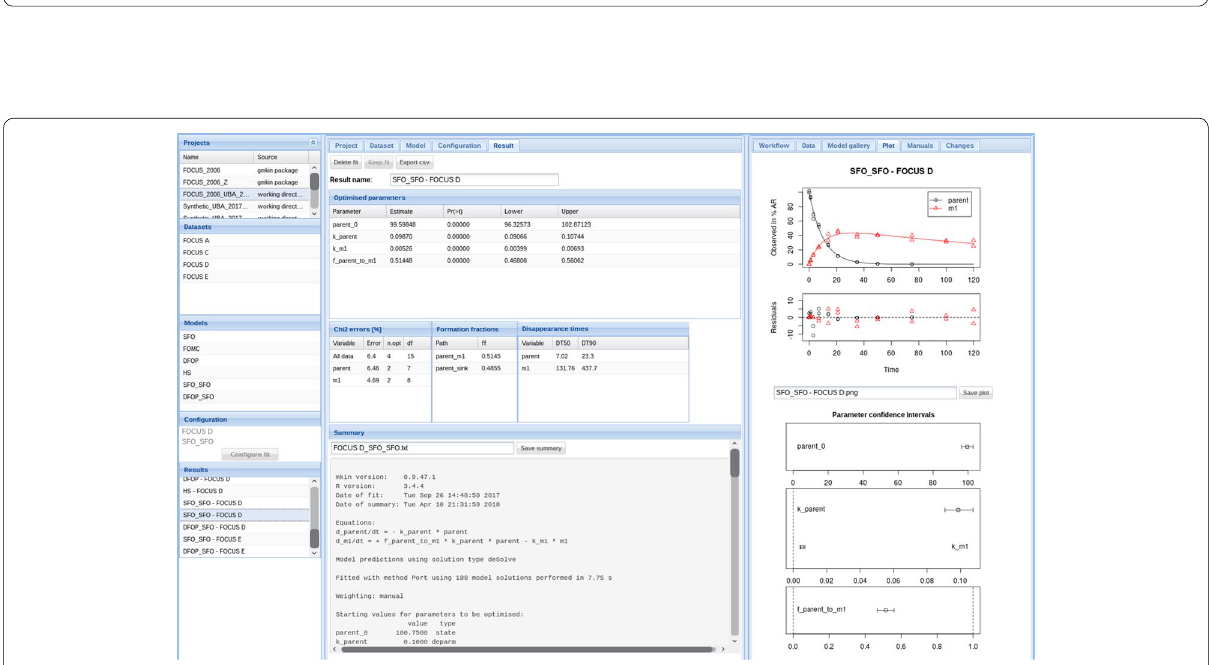
Fig. 4 Screenshot of gmkin 0.6.7 Datasets and models are listed on the left, numerical results and a summary are shown in the center and a plot of the fitted model is on the